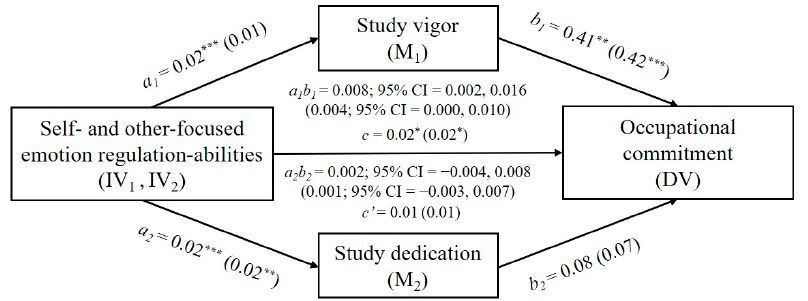
Figure 2. Graphical representation of the final mediator model. Note. Results for other-focused ERA as predictor are in parentheses. * p < 0.05; ** p < 0.01; *** p < 0.001. as predictor are in parentheses. * p < 0.05; ** p < 0.01; *** p <